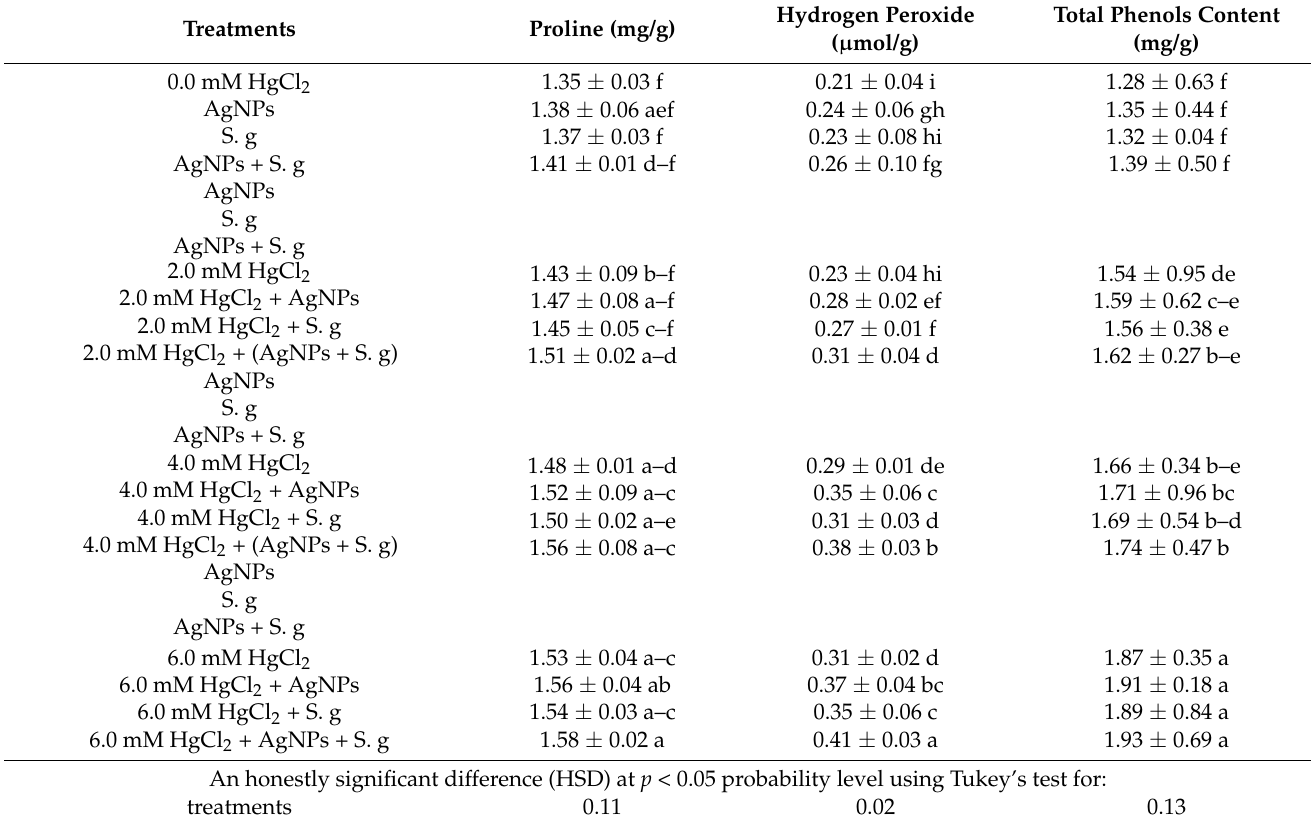
Table 3. Effect of AgNPs, Sphingobacterium ginsenosidiumtans (S. g), and their combination on proline, hydrogen peroxide, and total phenols content of Trigonella foenum-gracum L. plants under HgCl 2 stress (0, 2, 4, and 6